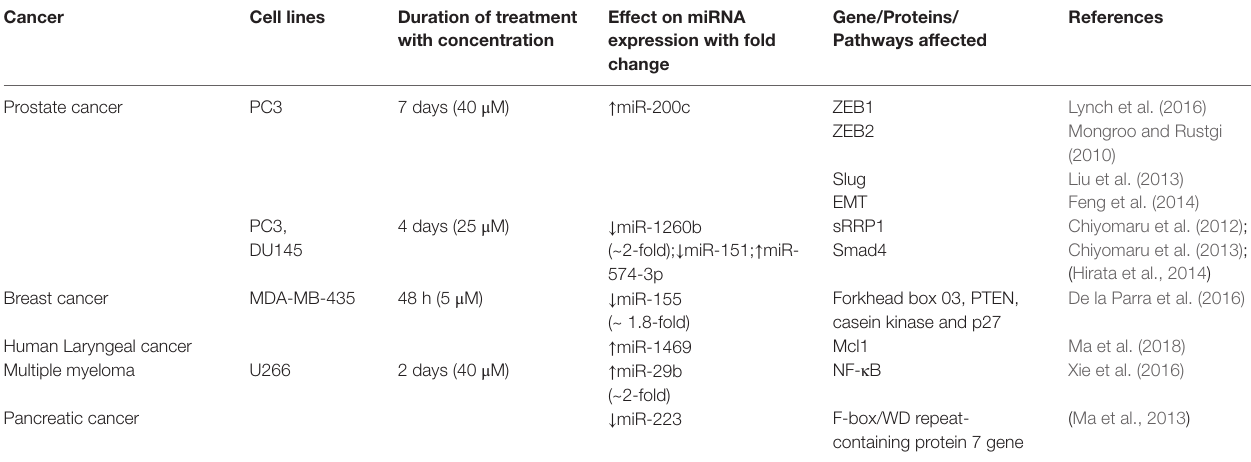
TABLe 2 | Effect of genistein on cancer-associated microRNAs